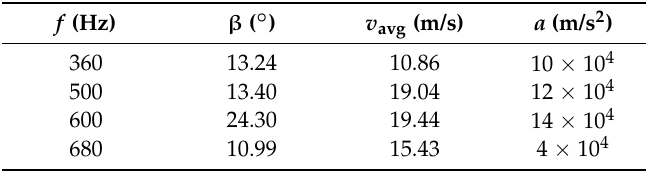
Figure 9. Movement and pressure of metal droplet in vacuum chamber.